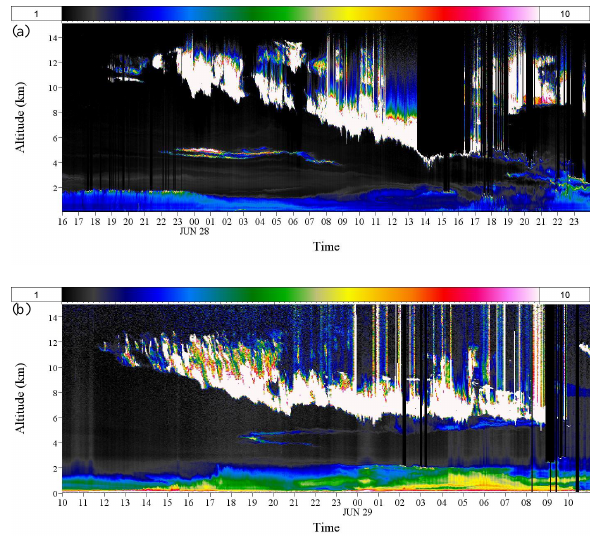
Fig. 9. False colour plots (using the same colour scale) showing the lidar backscatter ratio at 1064nm for (a) CORALNet Sherbrooke, and (b) CORALNet Acadia. The time and date (in 2011) are plotted in